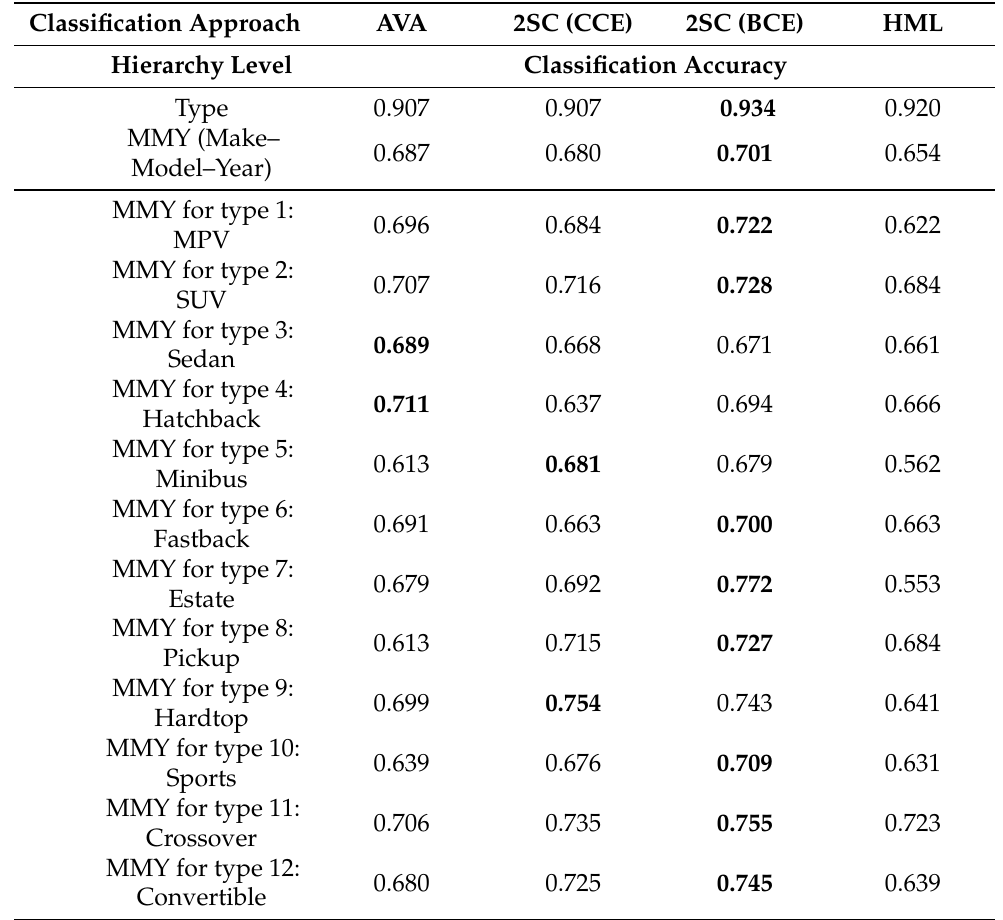
Table 3. Classification accuracy on our revisited CompCars dataset using different approaches: All-vs.-all (AVA), Two-step cascade (2SC), and Hierarchical multilabel (HML). The two-step cascade is realized with two variants, using either categorical (CCE) or binary (BCE) cross-entropy at the type-level classification. Best results per line are highlighted in